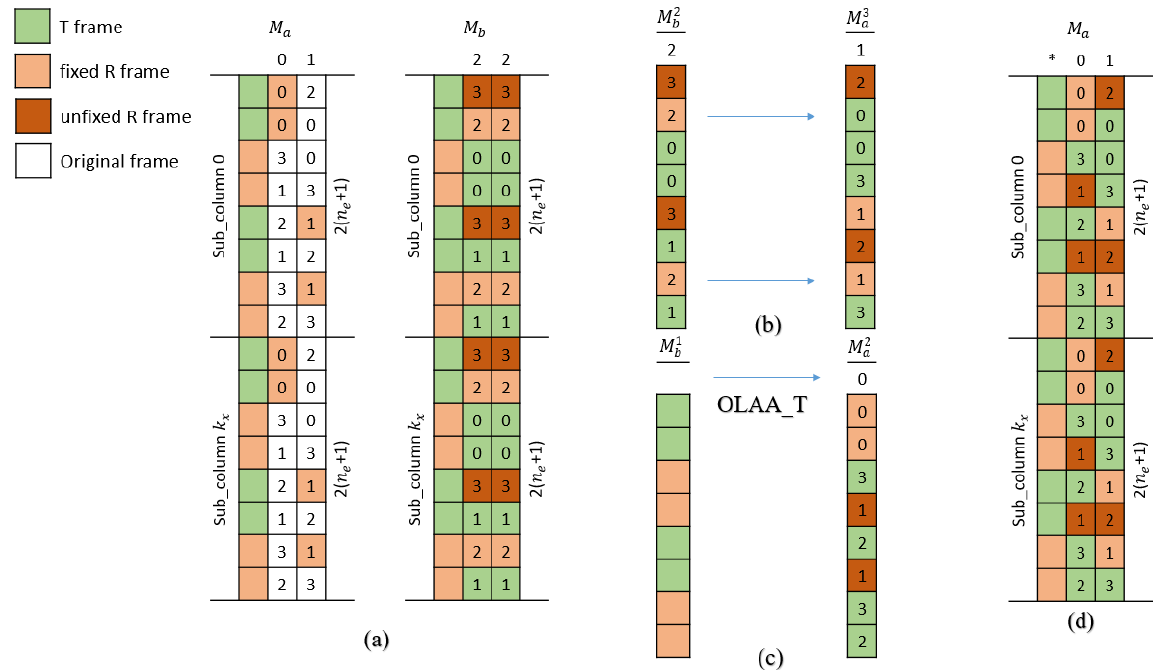
Figure 3. This figure illustrates how SU a allocates T and unfixed R frame symbols in the presence of an asynchronous SU b . The four panels depict the following steps: ( a ) the allocation of uFR a , ( b ) the selection of T frame and unfixed R frame symbol of M 3 a based on M 2 , ( c ) the selection of T frame and b unfixed R frame symbol of M 2 a based on M 1 , and ( d ) the complete M a b